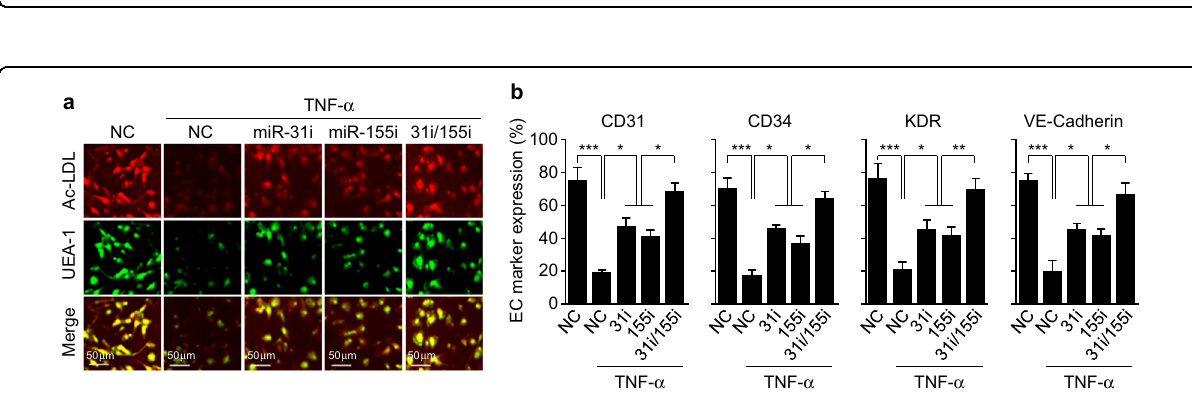
Fig. 5 TNF- α inhibits the differentiation of MNCs into EPCs via miR-31/155 biogenesis. CBMNCs were transfected with negative control for miRNA inhibitor (NC), miR-31 inhibitor (miR-31i or 31i), miR-155 inhibitor (miR-155i or 155i), or miR-31/155 inhibitors (31i/155i), followed by differentiation into EPCs in the presence or absence of TNF- α . a The differentiation of CBMNCs to EPCs was determined by double-positive staining with Dil-ac-LDL and FITC-UEA-1. b Cells were labeled with antibodies against EPC marker proteins and analyzed by fl ow cytometry ( n = 3). * P < 0.05, ** P < 0.01, and *** P <